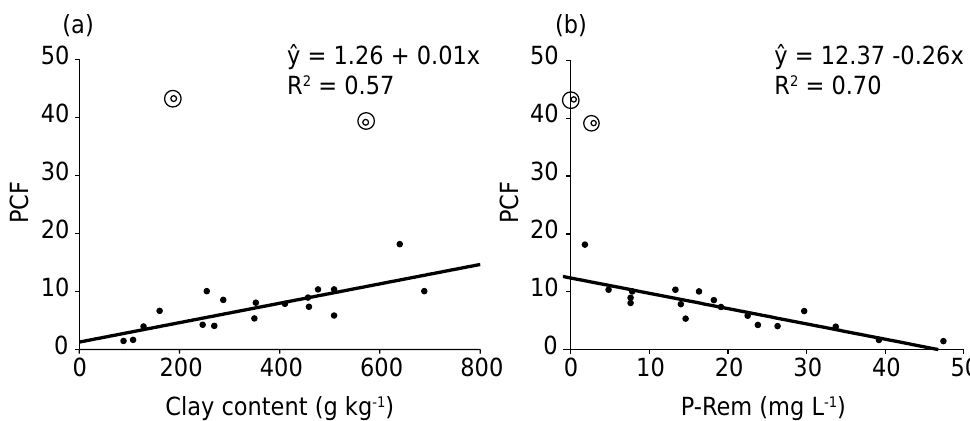
Figure 2. Regression between the P capacity factor (PCF) and the clay content (a) or the P-remaining values (P-Rem) (b). The outliers (circled points) were excluded from the regression calculation, for